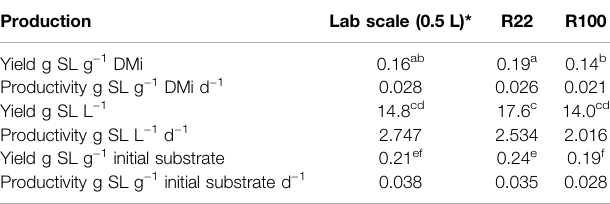
TABLE 1 | Comparison of maximum yields (obtained at 7 days) and maximum productivities (as measured after 5 days except for R100 at 6 days) at lab scale, R22 and R100. Different letters indicate values statistically different ( p < 0.05).